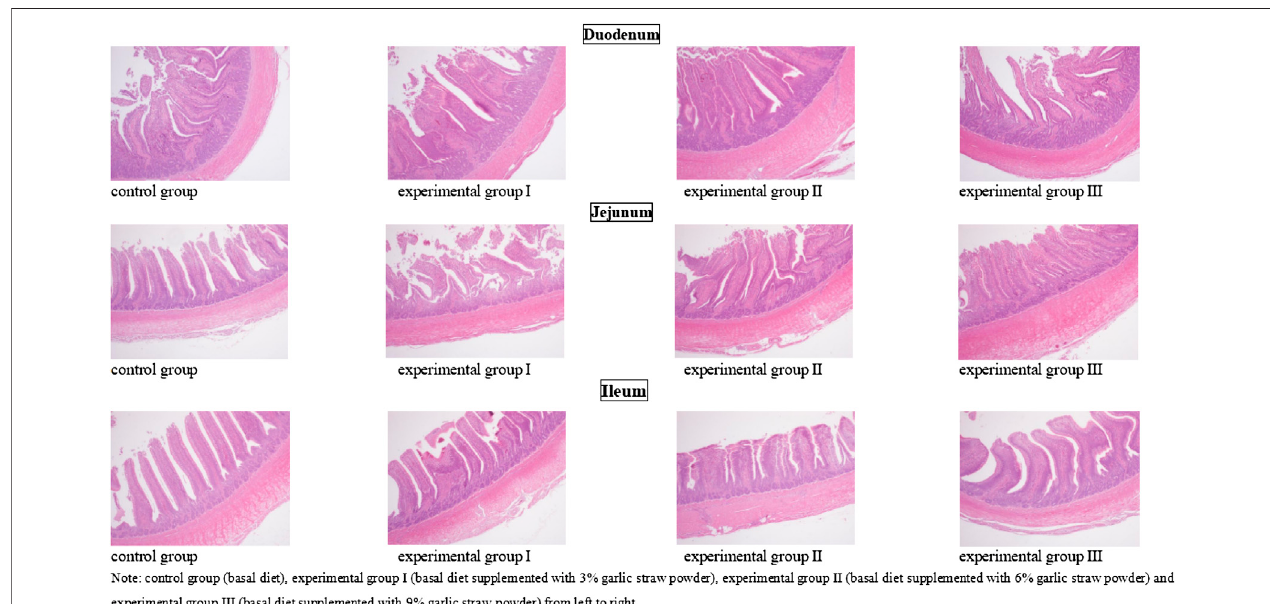
FIGURE1| Sections ofduodenum jejunum and ileum ofyellow-feathered broilers ineach group(40×).Note: controlgroup (basal diet), experimentalgroup I(basal diet supplemented with 3% garlic straw powder), experimental group II (basal diet supplemented with 6% garlic straw powder) and experimental group III (basal diet supplemented with 9% garlic straw powder) from left to